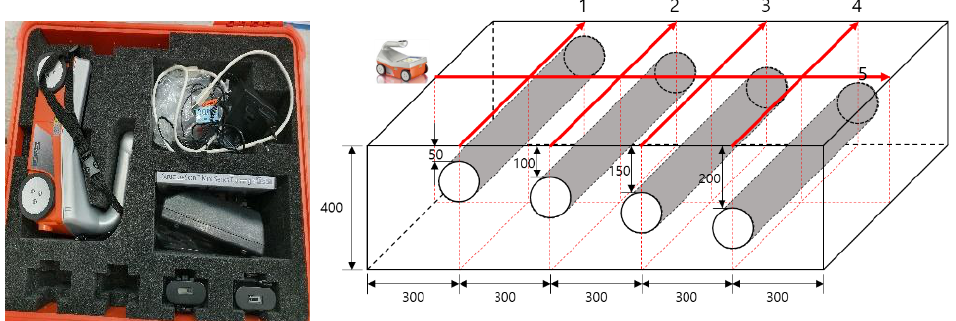
Figure 2. EM wave measuring equipment and test procedures (dimensions in mm).